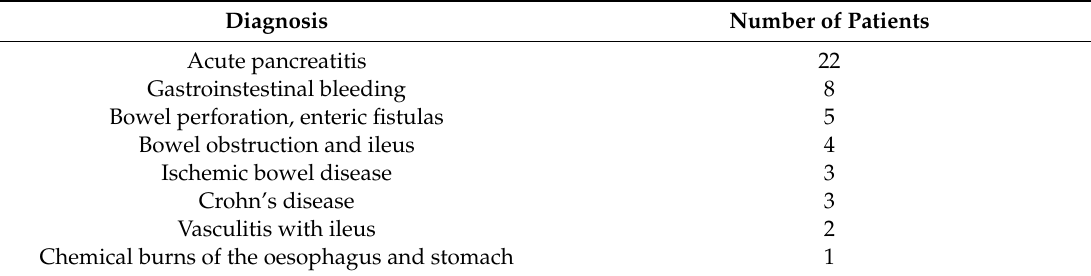
Table 1. Diagnosis of the patients in the